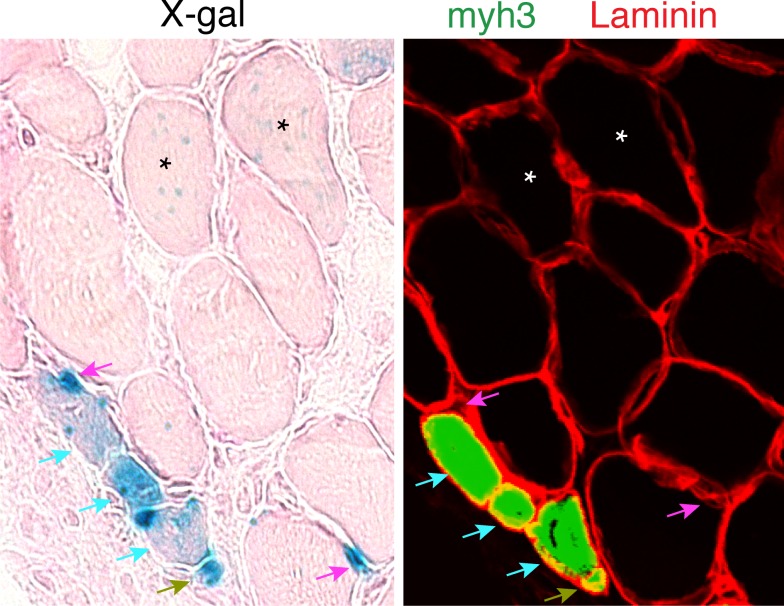
Day 7 MOV serial sections were stained with x-gal or immunostained with laminin and embryonic myosin (myh3) antibodies.Two populations of LacZ+ myofibers were observed. One exhibited punctate x-gal and was myh3- (stars) thus representing existing fibers that have fused with a MP. The second myofiber population exhibited stronger x-gal staining and was myh3+ (blue arrows) and these represent de novo myofibers. We also observed two different populations of small cells exhibiting x-gal staining, which we classify as non-myofiber. The first population was LacZ+ myh3+ (green arrows) which indicate differentiated myocytes, whereas LacZ+ myh3- (magenta arrows) depict myogenic progenitors.